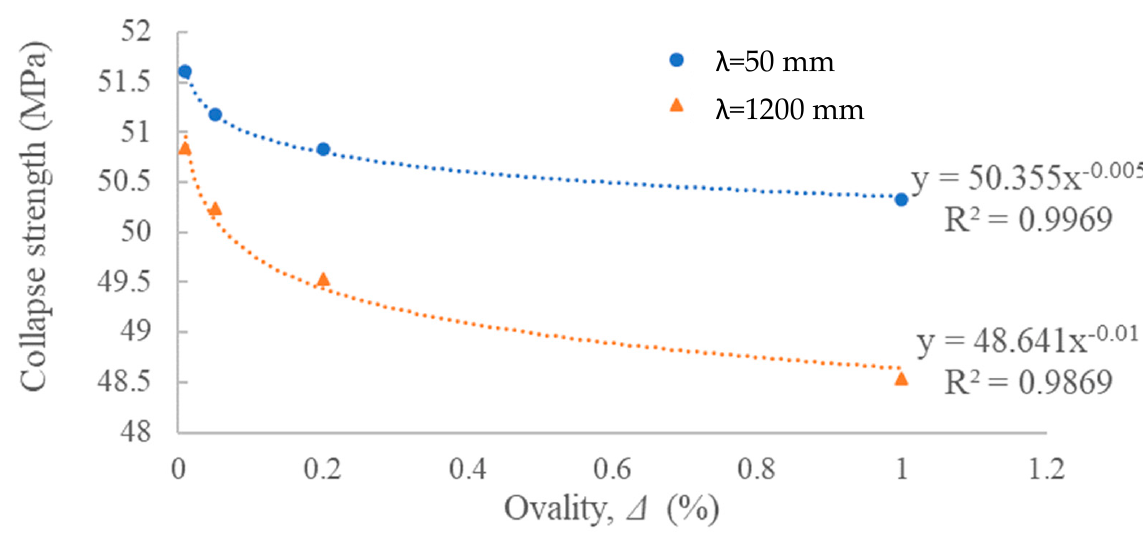
Figure 5. Relationship between collapse strength and ovality of case series of ‘313 de ’.